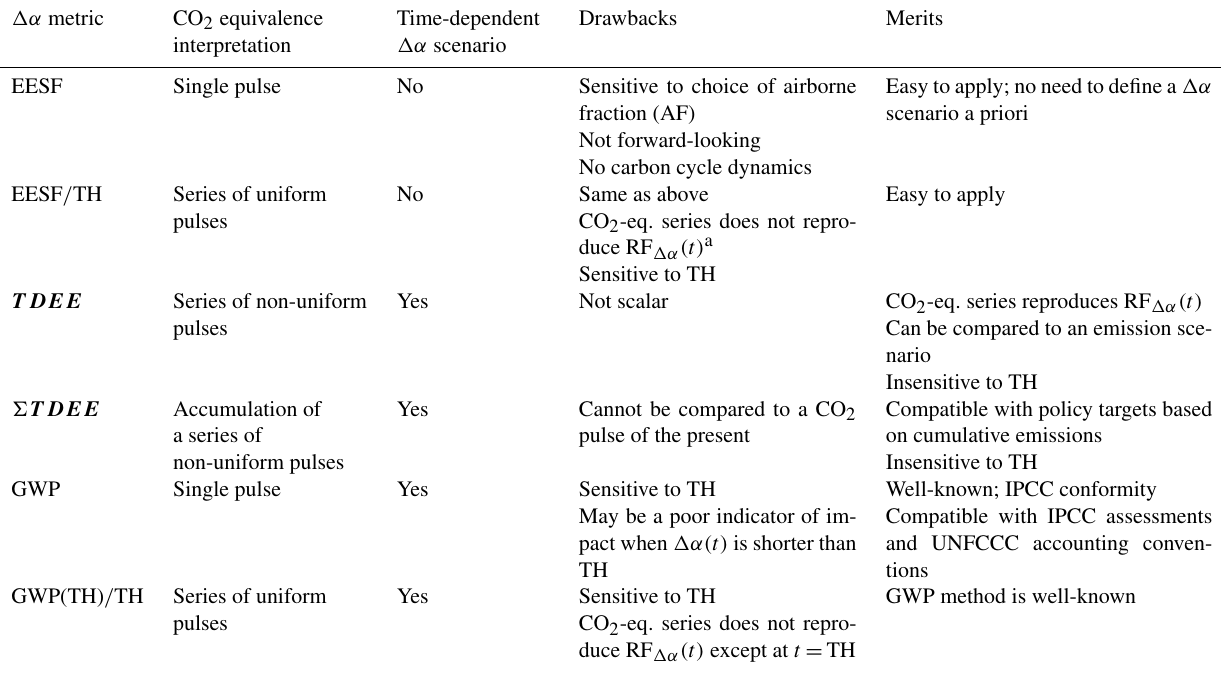
Table 3. Overview of distinguishing attributes, methodological differences, drawbacks, and merits of the six (cid:49)α metrics applied in the scientific literature included in this